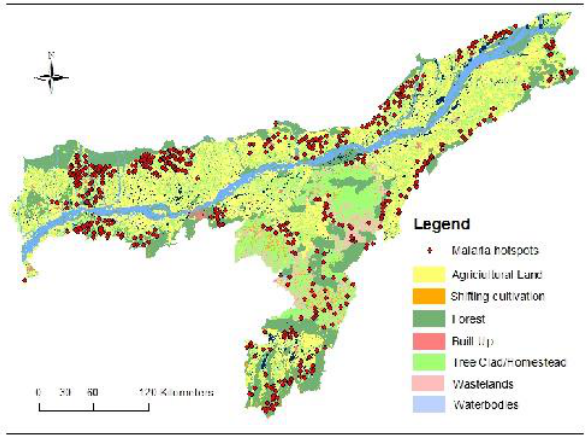
Figure 3. Malaria incidence hotspots with different land use/land covers